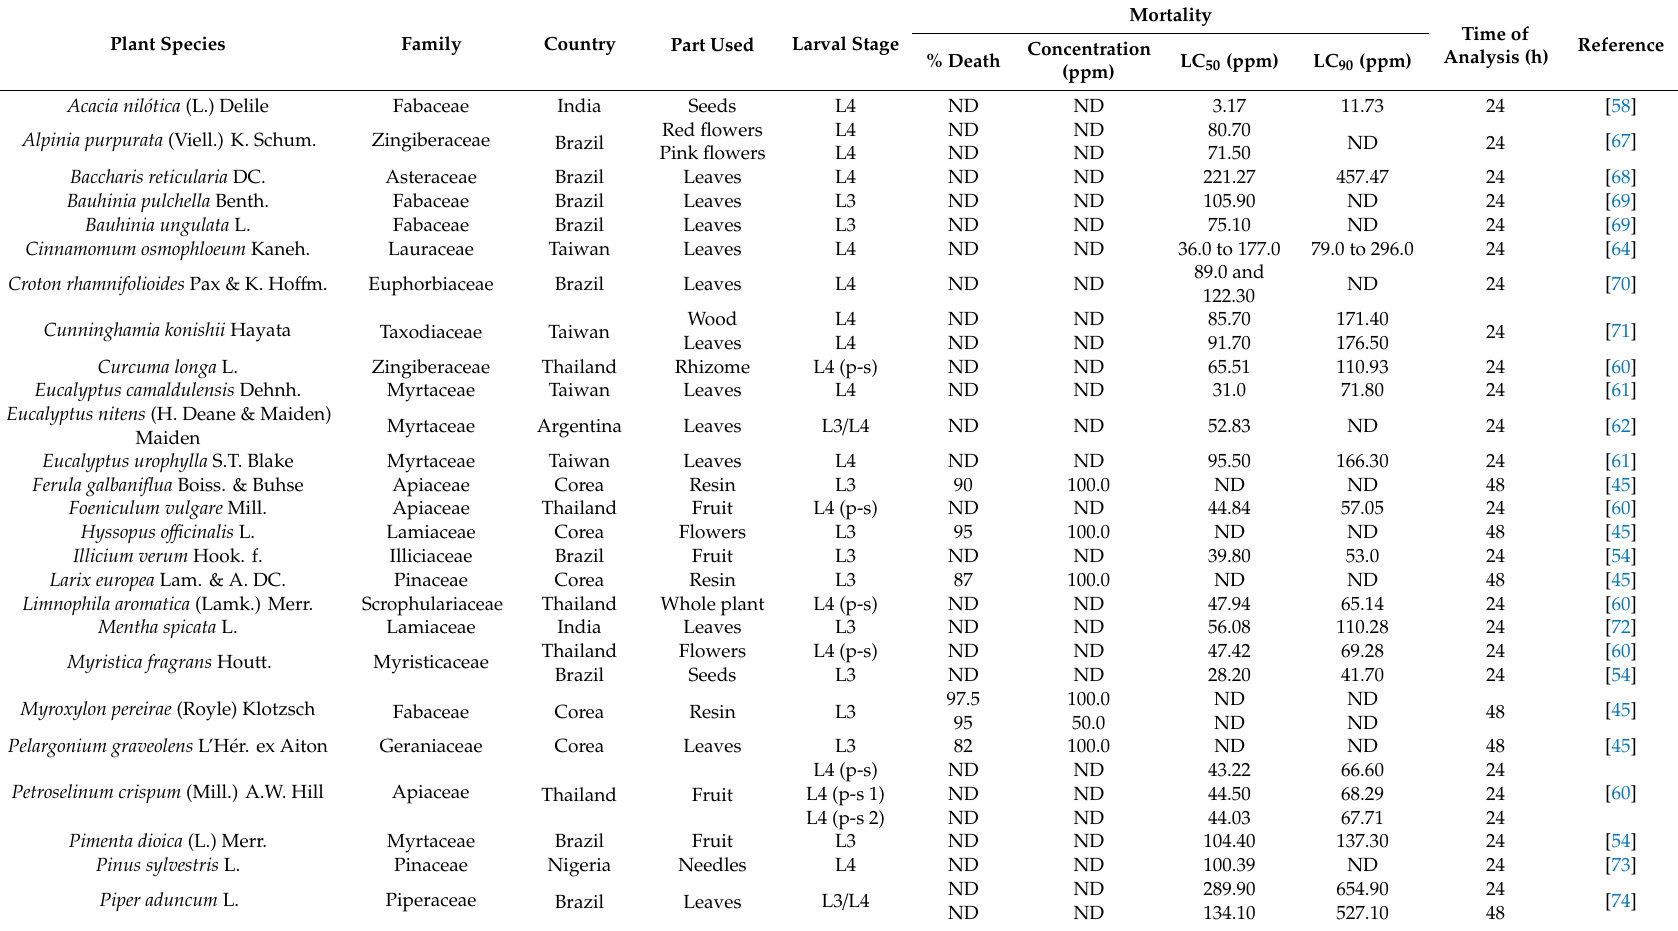
Table 1. Larvicidal activity of essential oils against the Ae. aegypti